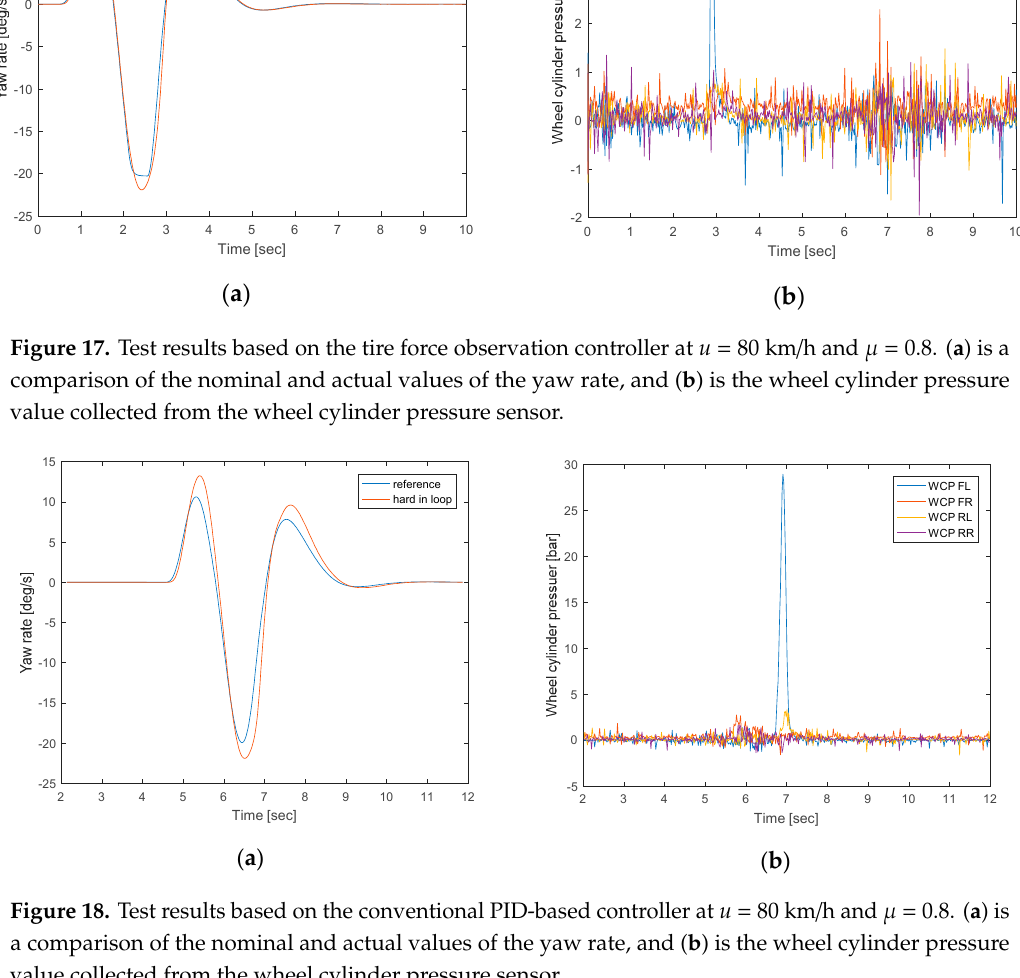
Figure 18. Test results based on the conventional PID-based controller at 𝑢 = 80 km/h and 𝜇 = 0.8. ( a ) is a comparison of the nominal and actual values of the yaw rate, and ( b ) is the wheel cylinder pressure value collected from the wheel cylinder pressure sensor.